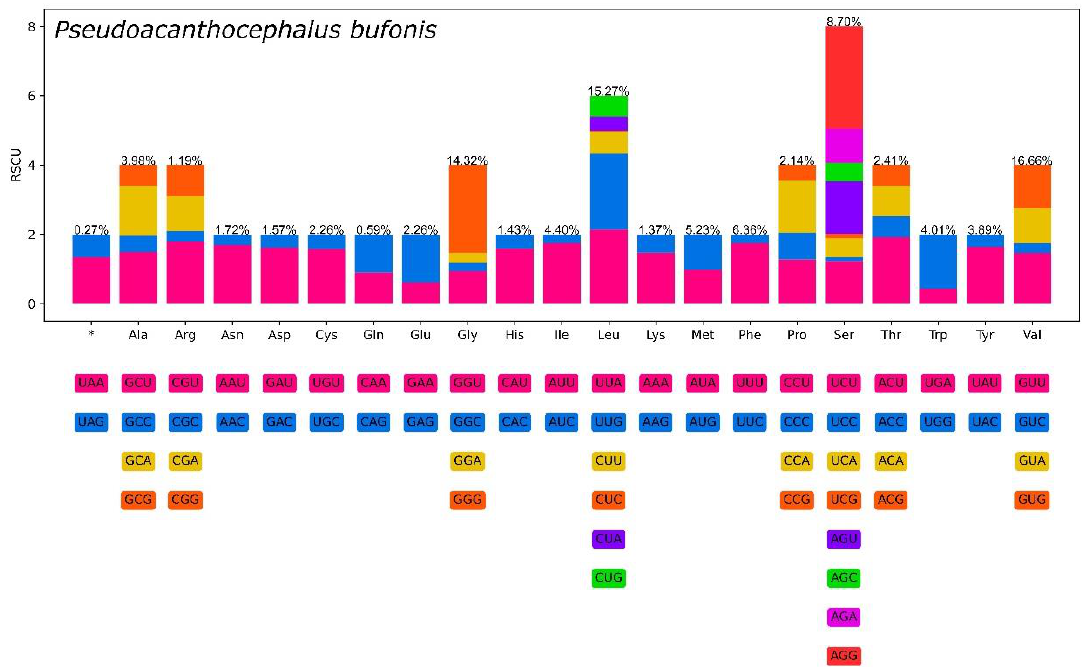
Figure 4. Relative synonymous codon usage (RSCU) of Pseudoacanthocephalus bufonis . Codon families (in alphabetical order) are provided below the horizontal axis. Table 6. Relative synonymous codon usage (RSCU) of Pseudoacanthocephalus bufonis (The asterisk represents termination codon).